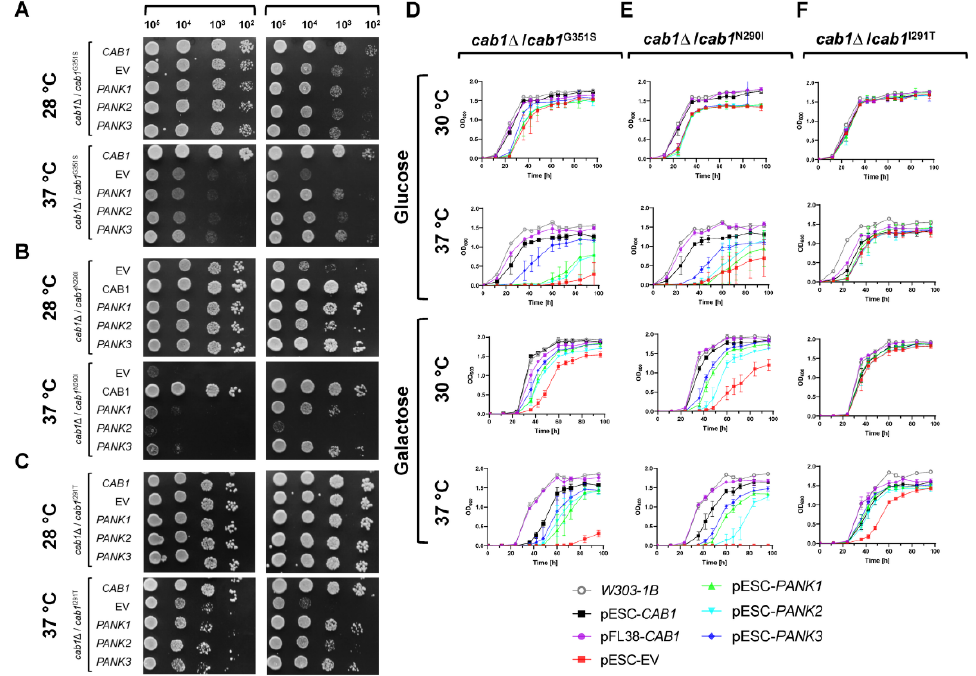
Figure 2. Complementation of the thermosensitive phenotype of CAB1 -defective yeast strains by human PanKs. ( A – C ) Equal amounts of serial dilutions of cells (10 4 , 10 3 , 10 2 , 10 1 cells/spot) from exponentially grown cultures of cab1 Δ / cab1 G351 S ( A ), cab1 Δ / cab1 N290I ( B ), and cab1 Δ / cab1 I291T ( C ) mutant strains carrying pFL38/ CAB1 and pESC- URA3 vector containing the different h PANK gene were spotted onto SC medium supplemented with the indicated carbon sources and incubated at 28 °C and 37 °C. Yeast growth was monitored over time and images collected 2 or 3 days post-inoculation. ( D – F ) Growth rates of cab1 Δ / cab1 G351S ( D ), cab1 Δ / cab1 N290I ( E ), and cab1 Δ / cab1 I291T ( F ) strains carrying the empty vector (EV), CAB1 and human PANK s in liquid media on glucose or galactose at 30 °C vs 37 °C (from top to bottom). Yeast cells were inoculated in minimal medium without uracil and tryptophan but containing either 2% glucose or 2% galactose at a cell density of 10 4 cells/ml. Optical density measurements at 600 nm (OD 600 ) were determined at the indicated time points. Data for liquid assays represent three biological replicates ( n = 3) and the plotted graphs represent the average ± SEM .